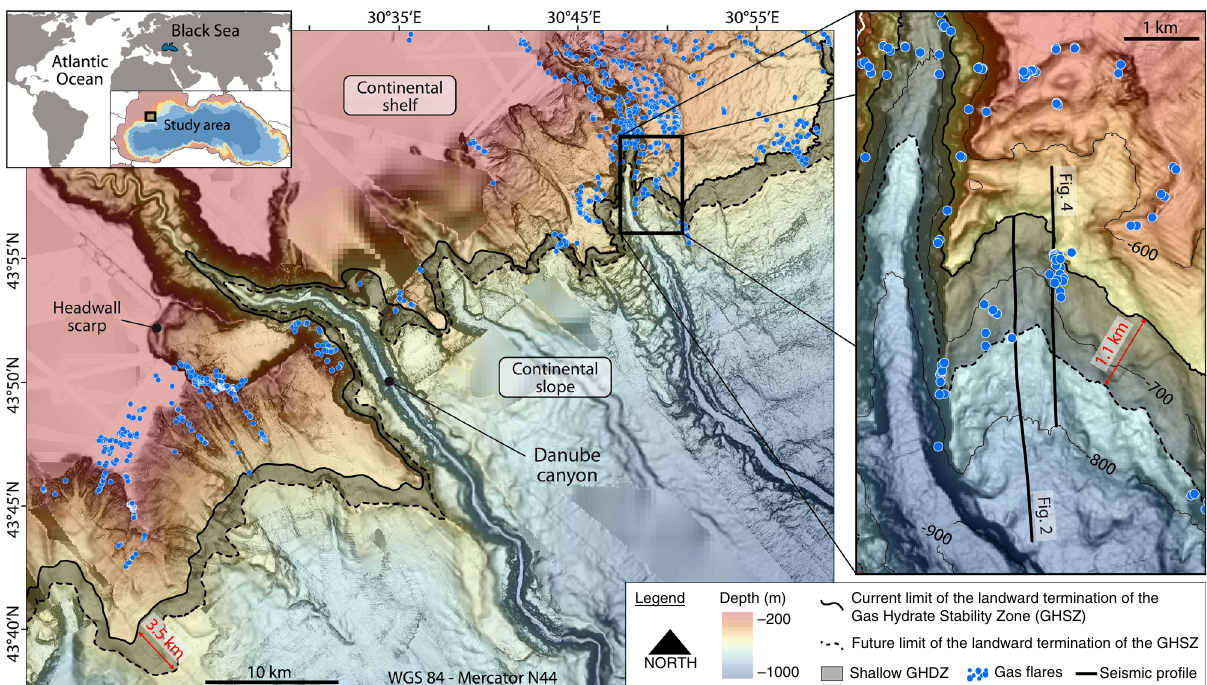
Fig. 1 Gas Hydrate Destabilization Zone in the Romanian sector of the of the Black Sea margin. The GHDZ, area between the black line and the black dashed line, has been determined in the Romanian sector of the Black Sea where the continental shelf and slope are incised by the Danube canyon and several submarine scarps. The GHSZ is comprised between the modern and the future (5000 yrs) landward termination of the GHSZ that correspond to the 660 and 720 mbsl bathymetric contours respectively. Gas fl ares (blue points), non-randomly distributed, are located outside the GHSZ and within the GHDZ. They are observed within the shipborne RESON 7150 multibeam swath along the vessel track indicated in the Supplementary Fig. 2. The inset shows the study area with the location of the seismic pro fi les used in the present